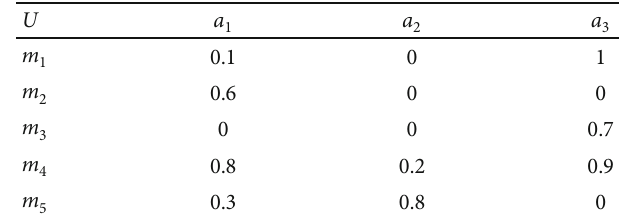
Table 2: Representation of the fuzzy soft set ð G , A Þ